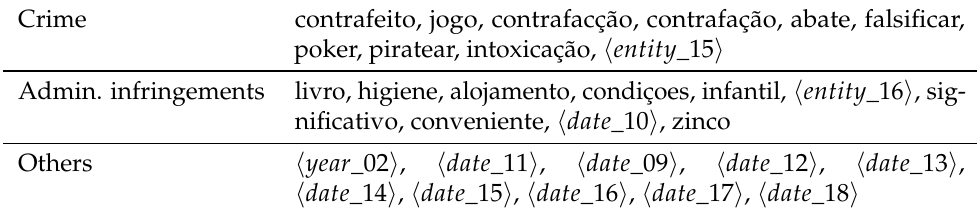
Table 12. Top-10 features for infraction severity prediction using the base techniques with SVM. Crime